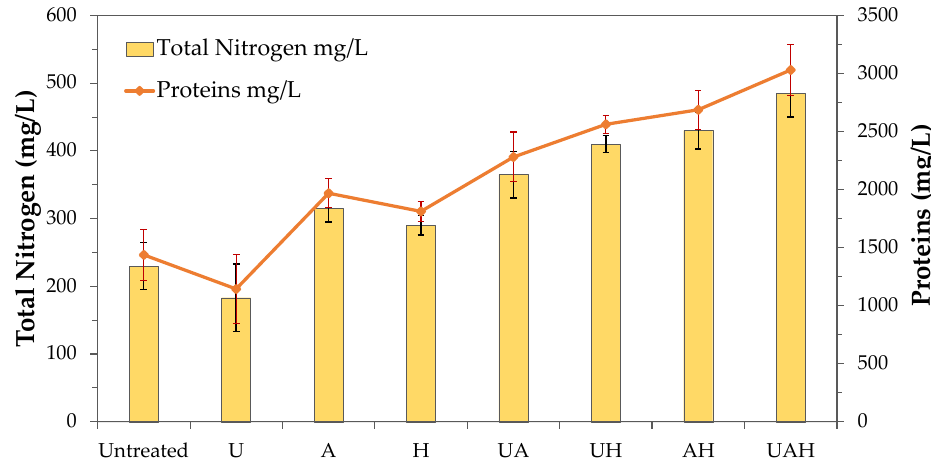
Figure 3. Effect of pretreatments on the concentration of total nitrogen and protein release.